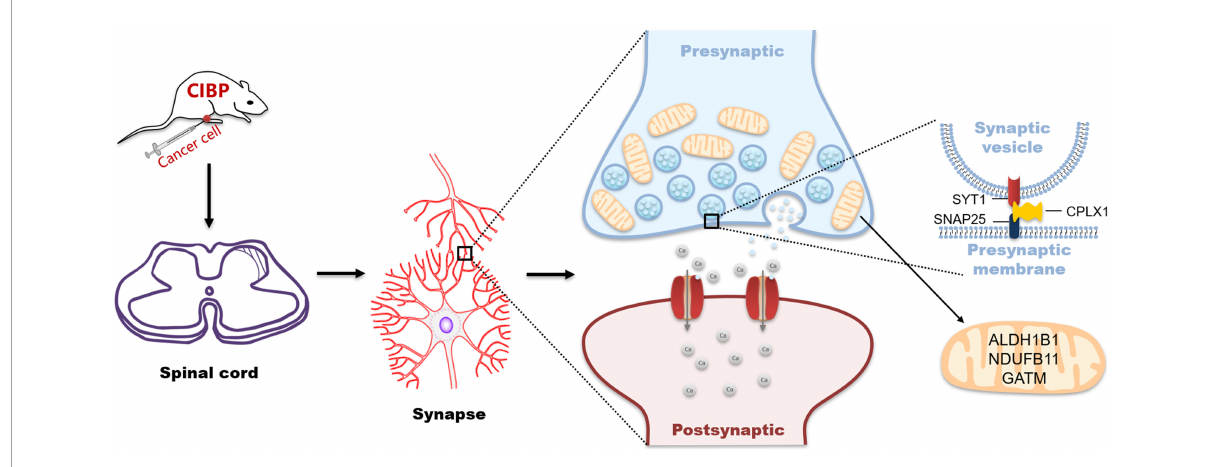
FIGURE7 Schematic representation for changes in synaptic- and mitochondrial-related proteins in the spinal cord during cancer pain